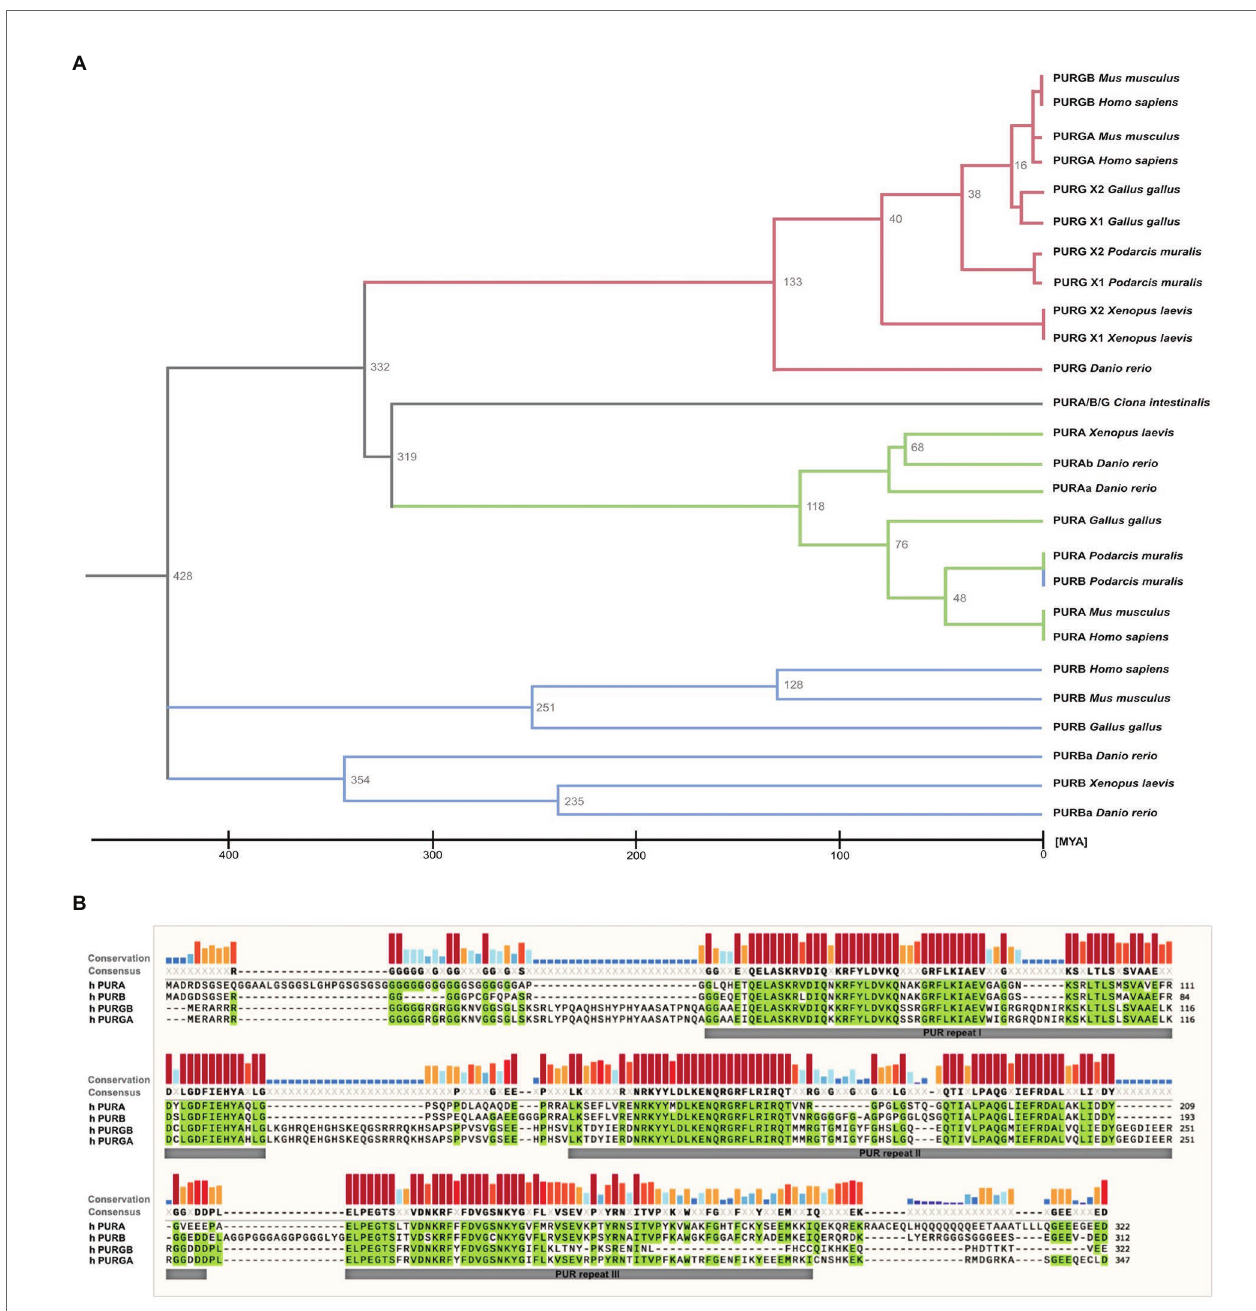
FIGURE 2 | Sequence similarities between PUR-family proteins. (A) Phylogenetic tree of the PUR-proteins of selected species. The tree shows evolutionary time on the X axis and indicates a differentiation of the PUR proteins between 428 and 319 Million Years Ago (MYA). The tree was inferred using the RelTime method and was computed using one calibration constraint. Branch lengths were calculated using the Maximum Likelihood (ML) method and the JTT matrix-based substitution model. A discrete Gamma distribution was used to model evolutionary rate differences among sites. The phylogenetic analysis was performed with the program MEGAX (Hall, 2013; Mello, 2018). (B) Amino acid sequence alignment of human PURA, PURB, PURG variant A, and PURG variant B. Sequence identity is highlighted in green. Whereas human PURA and PURB proteins share 70% sequence conservation, PURG has 48% identity to PURA and thus is more divergent. For all paralogs, sequence similarity is notably higher within the PUR repeats. The alignment was executed using the MUSCLE algorithm and program